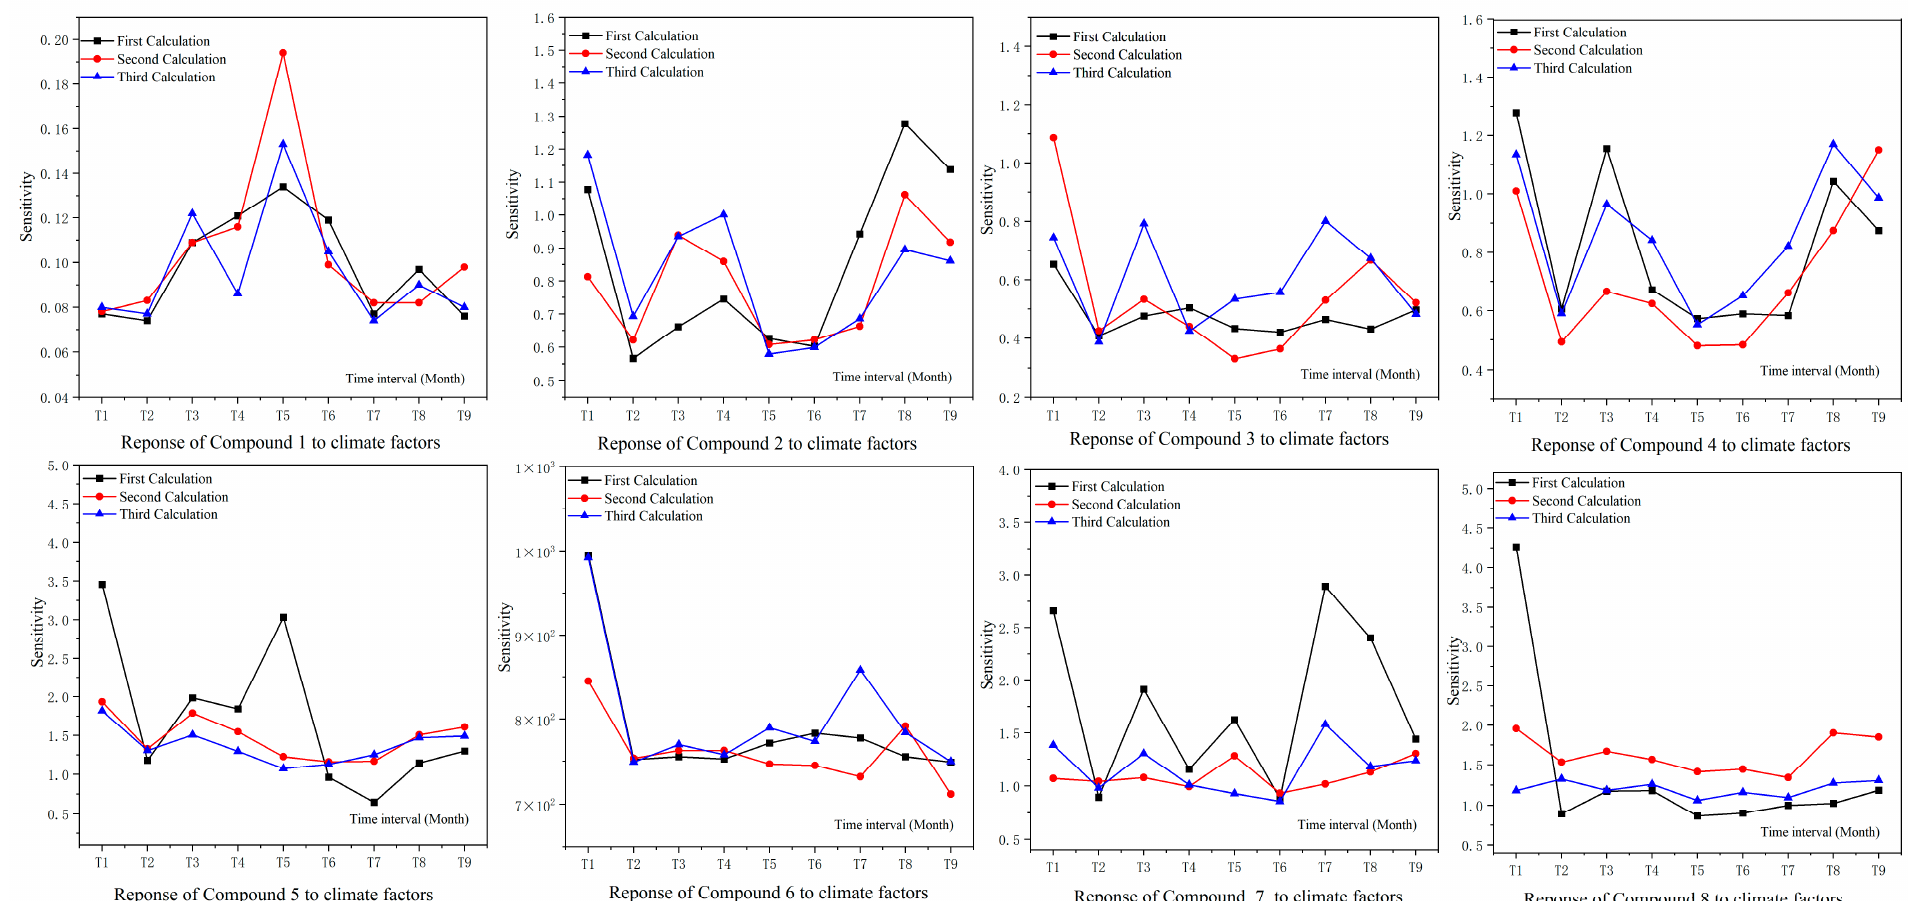
Figure 8. Compound 1–8: isotrifolin, rutin, myricetin deoxyhexoside, quercetin-3-rutinoside, luteolin 6-C-glucoside, quercitrin, genestein G2, luteolin-4’- O -(6”- trans-caffeoyl)- β - D -glucopyranoside.